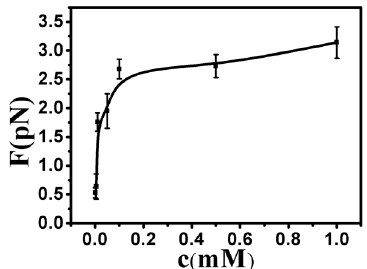
Figure 8. The curve of condensing force at different concentrations of Ph 4 As + .